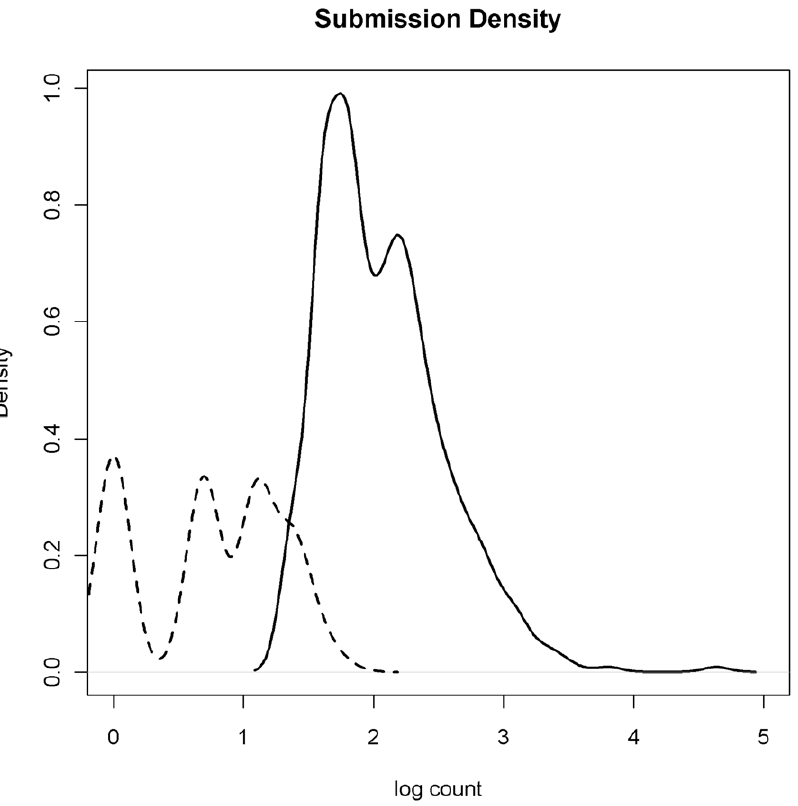
Figure 5. Submission count densities. Density of the log count of submissions in state one (dashed) and state two (solid).